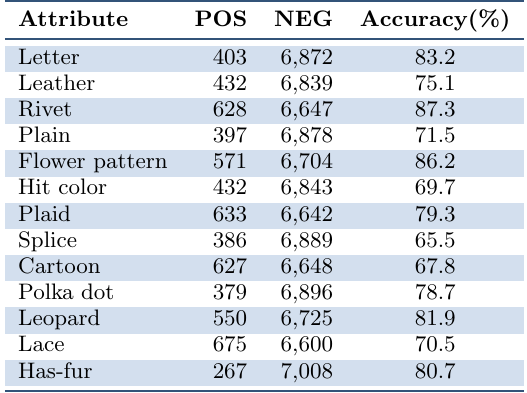
Table 1: The information on fashion elections and their de-